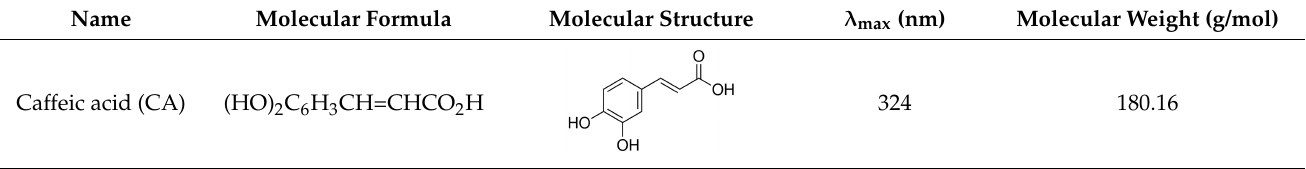
Table 1. Molecular formula, molecular structure, maximum absorption wavelength and molecular weight of caffeic acid (CA) [31].